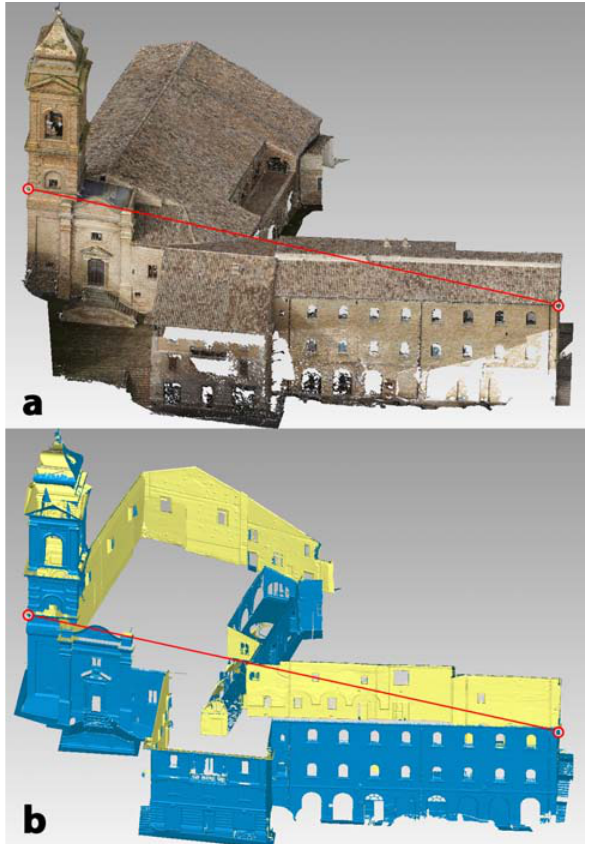
Figure 8. The red line used as a references lenght to align the point clouds captured from UAV (a) and TLS